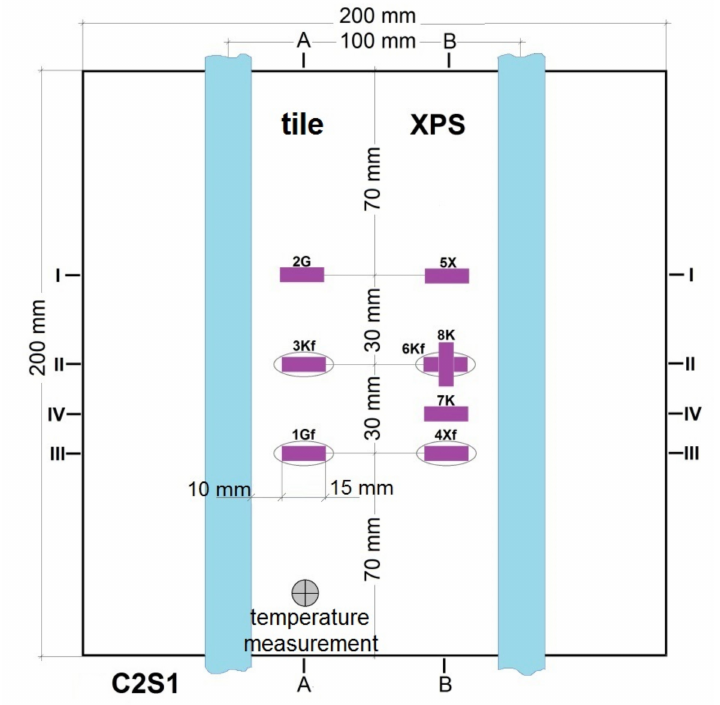
Figure 5. Horizontal section of the test model in the centre with C2S1 adhesive, without lamellas.